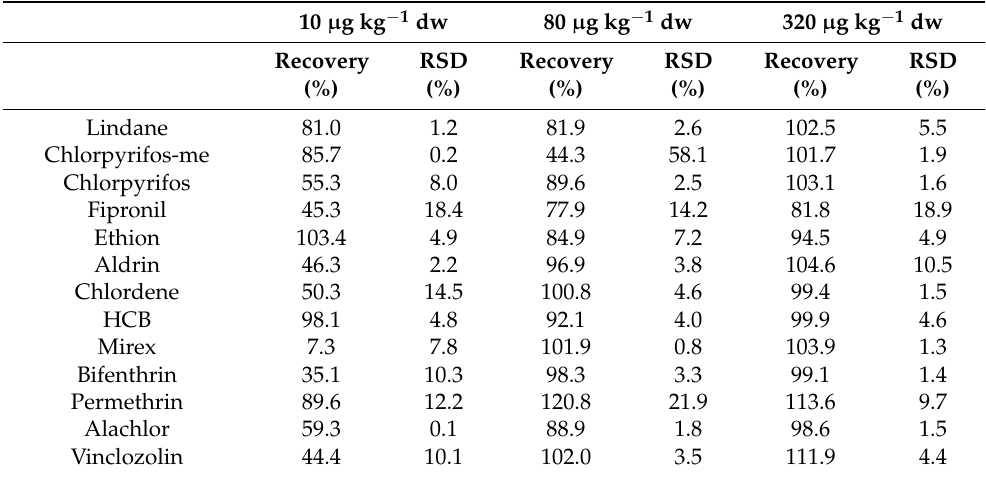
Table 3. Interval (minimum–maximum) of mean extractive recoveries (%) and RSD for the analytes at three concentrations for the lean fish